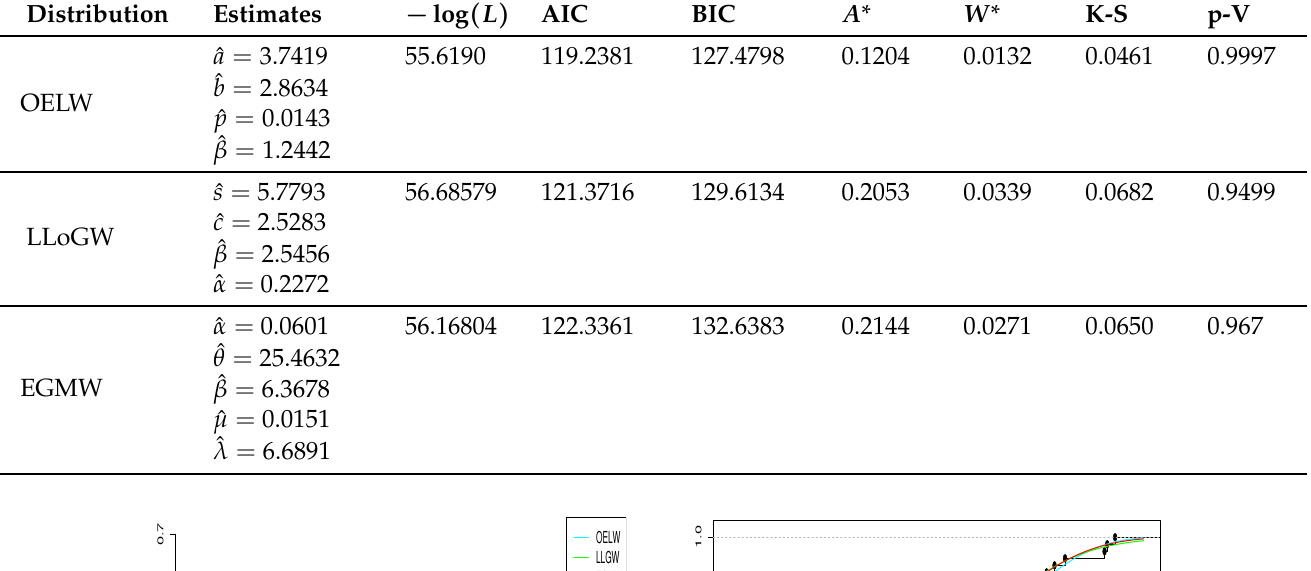
Table 8. Estimated values, log-likelihood, AIC, BIC, A *, W *, K-S and p-V for the carbon dioxide data set.